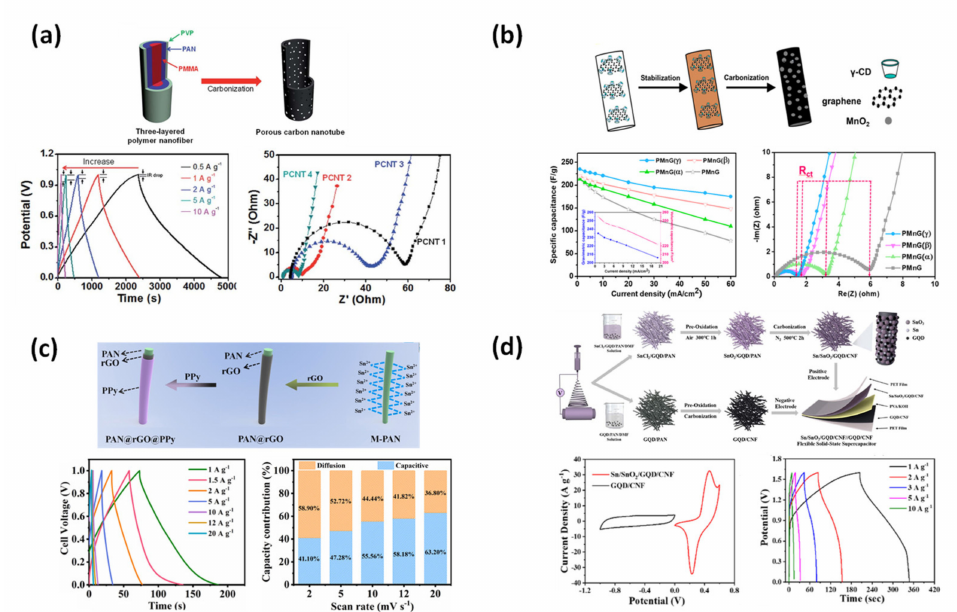
Figure 12. ( a ) Hollow, porous CNFs for supercapacitors from dual nozzles, with PMMA for the inner nozzle and PAN/PVP for the outer nozzle [90]. ( b ) Porous CNFs decorated with MnO 2 from the mixed precursor of PAN, CD surfactant graphene, and graphene for the supercapacitor [92]. ( c ) Multilayer CNFs, rGO, and PPy for the application of the supercapacitor [93]. ( d ) Supercapacitor from couple electrode Sn/SnO 2 /GQD/CNFs versus GQD/CNFs